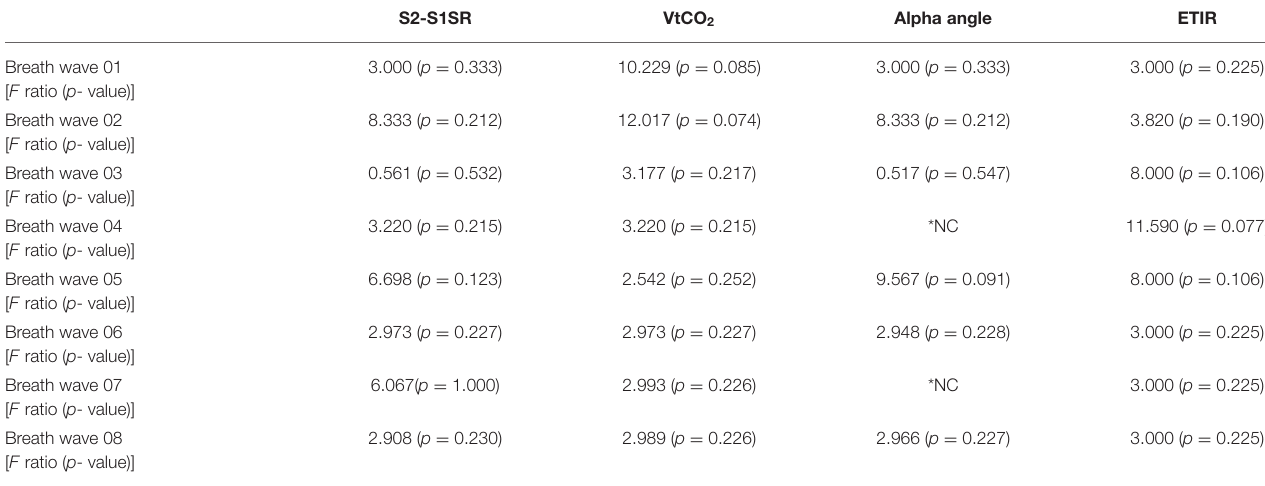
Breath wave 01 [ F ratio ( p -